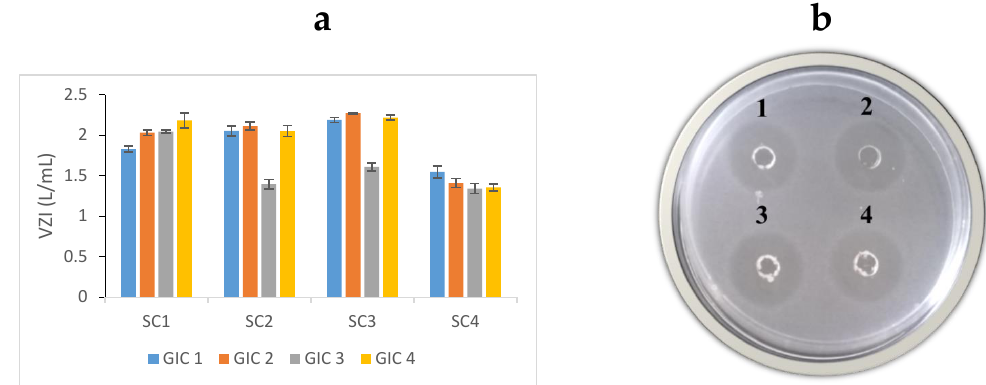
Figure 6. ( a ) Values of the volumetric zone of inhibition (VZI) obtained from growth inhibition combinations (GICs), i.e., GIC1, C. pyralidae Y1117 and P. kluyveri Y1125 (1); GIC2, C. pyralidae Y1117 and P. kluyveri Y1164 (2); GIC3, P. kluyveri Y1125 and Pichia kluyveri Y1164 (3); and GIC4, C. pyralidae Y1117 , P. kluyveri Y1125, and P. kluyveri Y1164 (4) against spoilage yeast consortia (SC), i.e., SC1 ( D. anomala and D. bruxellensis ), SC2 ( D. anomala and Z. bailii ), SC3 ( D. bruxellensis and Z. bailii ), and SC4 ( D. anomala , D. bruxellensis , and Z. bailii ). ( b ) An example of a plate showing the VZI obtained from the GICs against SCs. The values presented are the means of three replicates with the standard deviation ranging between 0.004 and 0.09.